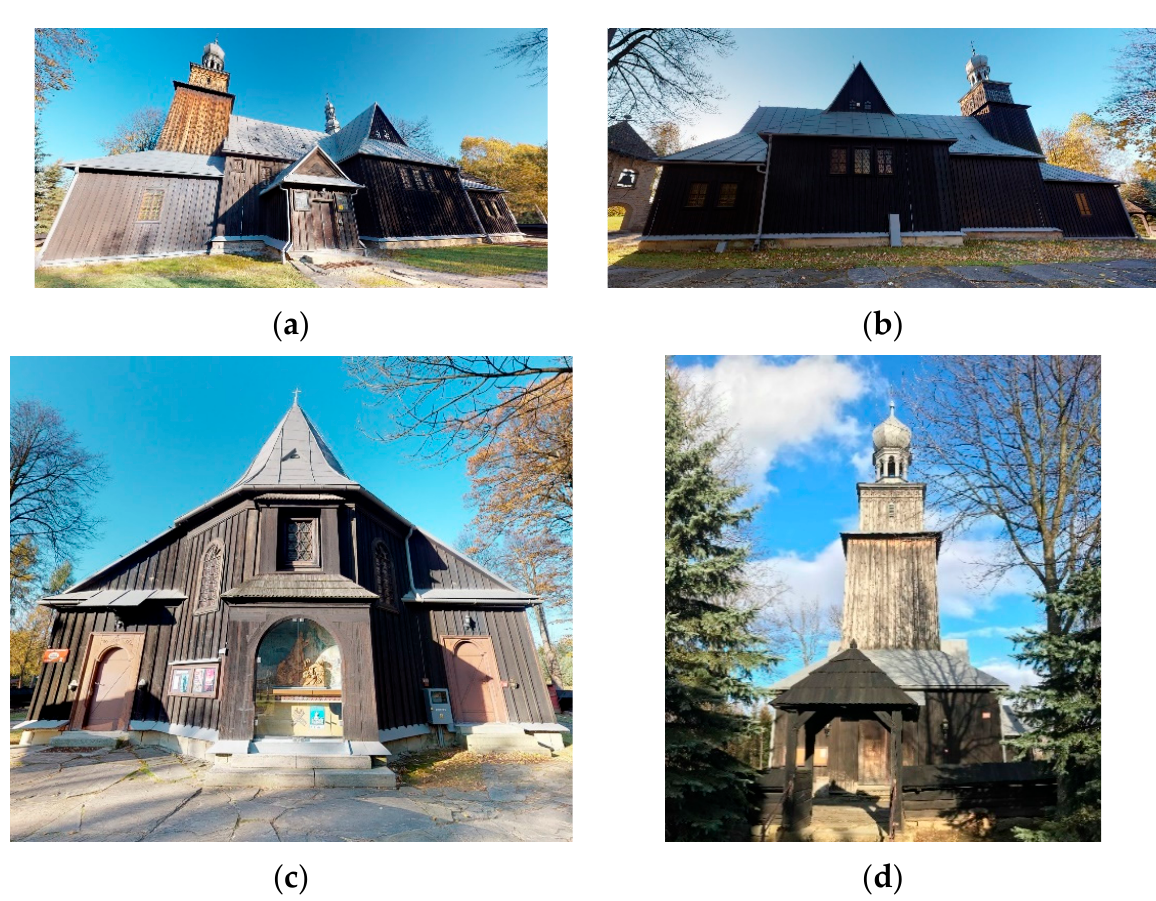
Figure 2. The elevations of the research object: ( a ) south; ( b ) northern; ( c ) eastern; ( d ) western.